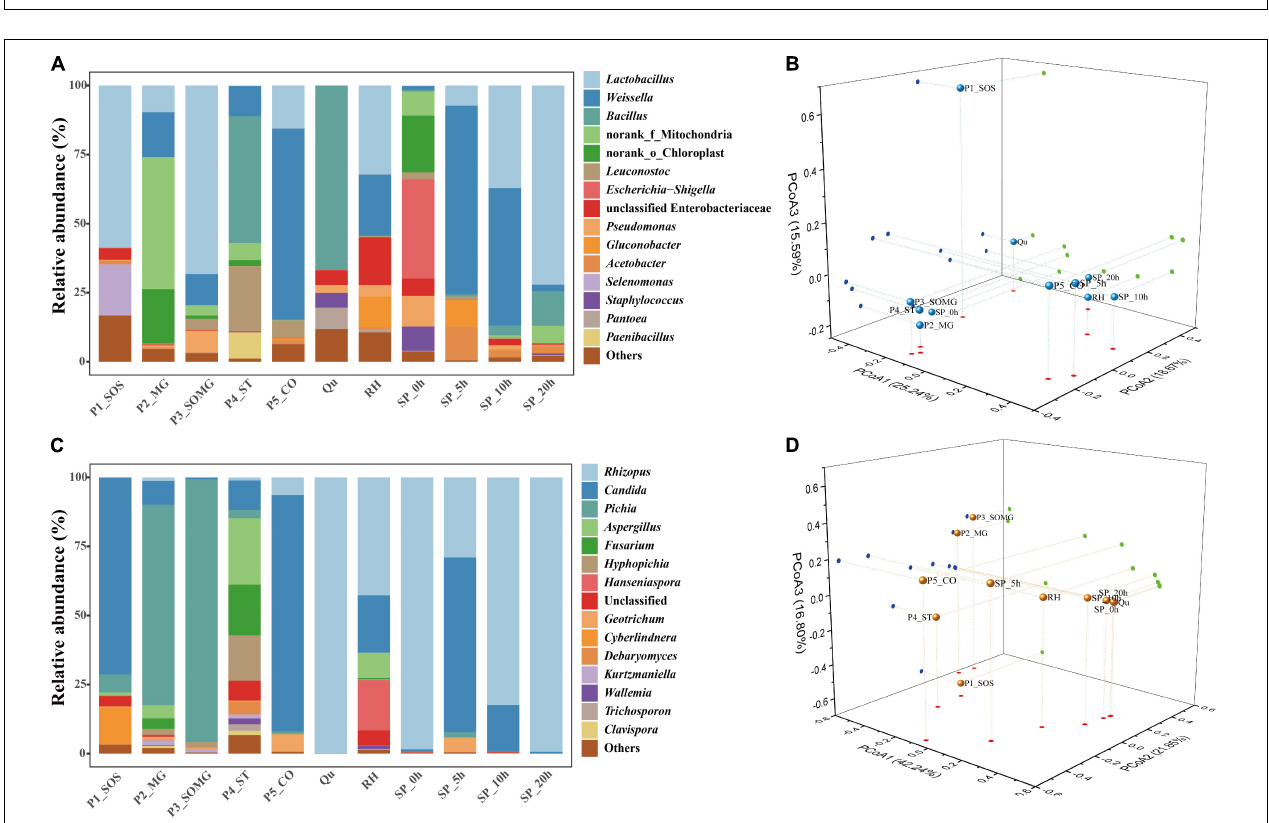
FIGURE 3 | Relative abundance of bacterial (A) and fungal communities (C) in pretreated and saccharified samples. PCoA analysis of the bacterial (B) and fungal communities (D) , based on the Bray–Curtis distance.